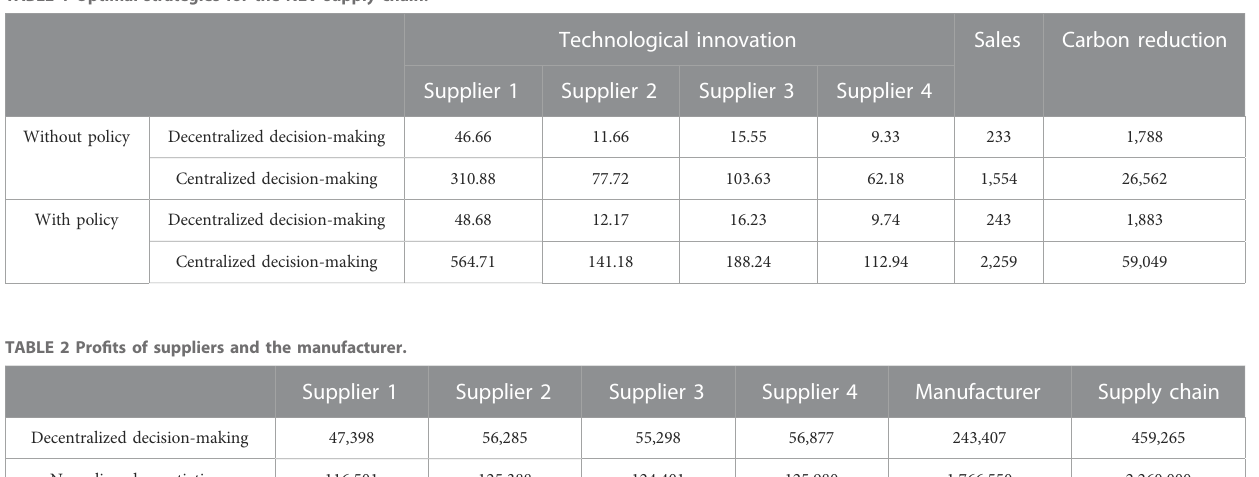
TABLE 1 Optimal strategies for the NEV supply chain.